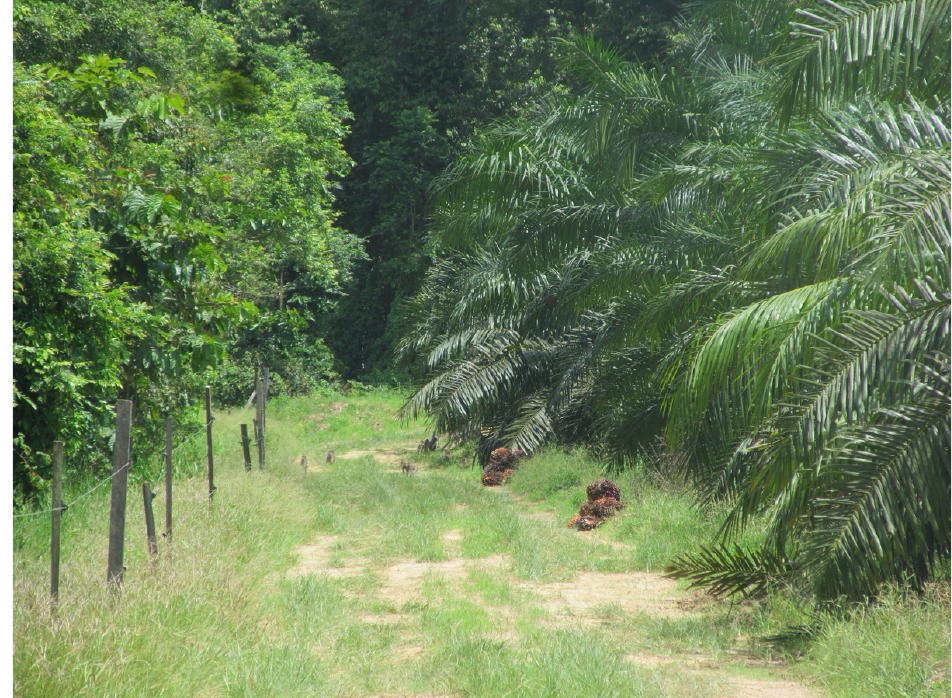
Figure 4. Sun bear habitat has been severely disrupted by oil palm plantations, but a big question is how much they use the fruits in the plantations. Shown here are oil palm fruits that were cut from trees and piled along a road at the boundary of the plantation and forest (before being picked up), easily accessible to sun bears. Bears thus do not have to climb and damage trees to obtain the fruit, and because they visit plantations at night, they are often not detected by workers [106]. Photo: D. Garshelis.